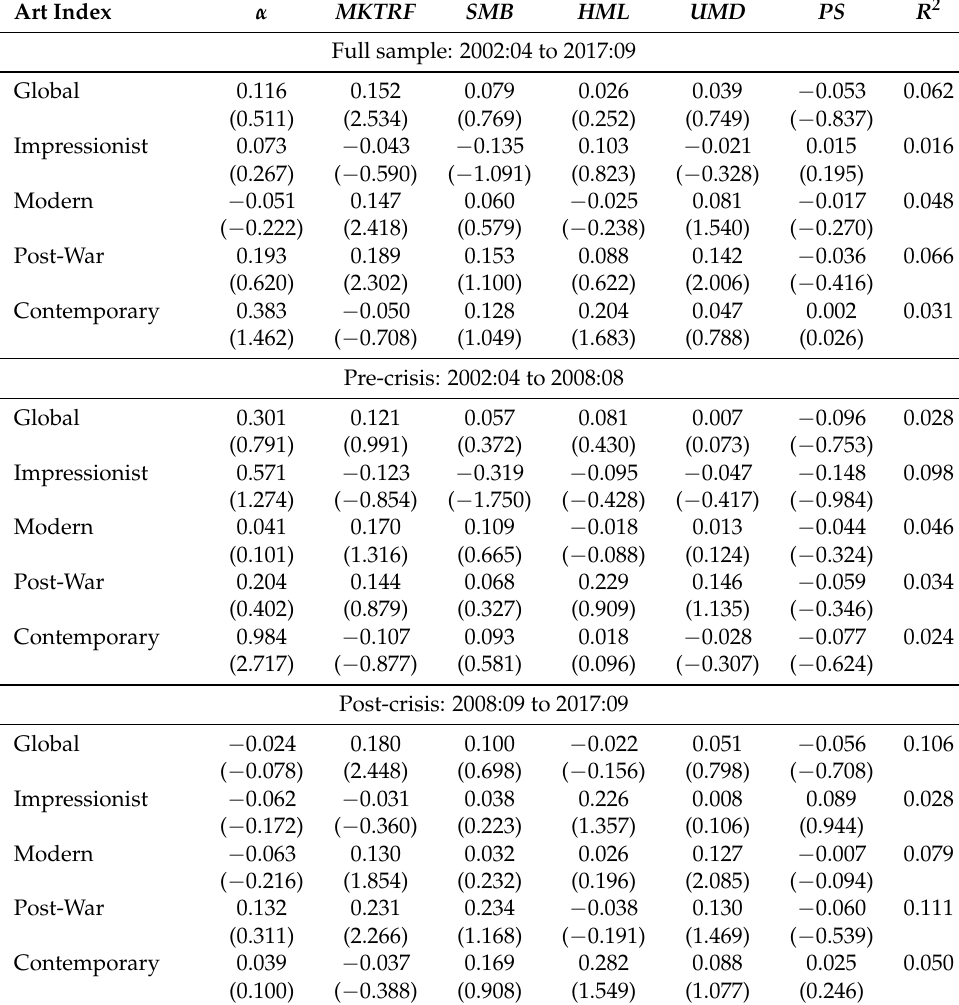
Table 5. The table reports the results of time-series regressions of the monthly returns associated with each art index on the three factors of Fama and French (1993) augmented with the momentum factor (UMD) of Carhart (1997) and the liquidity factor (PS) of Pástor and Stambaugh (2003). α is expressed as a percentage per month, and Newey–West t -statistics are reported in parentheses. Note that returns for the contemporary art index begin in